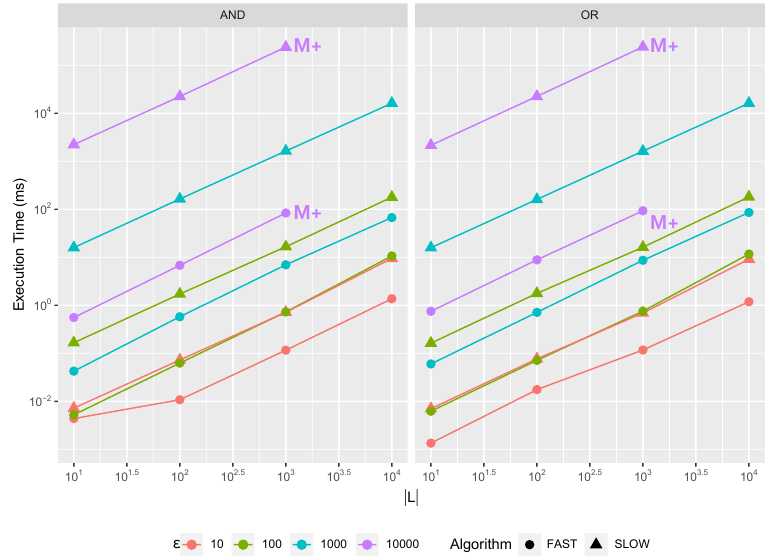
Figure 7. Results for the fast set operations Section 6.1 against the traditional logical implementation.